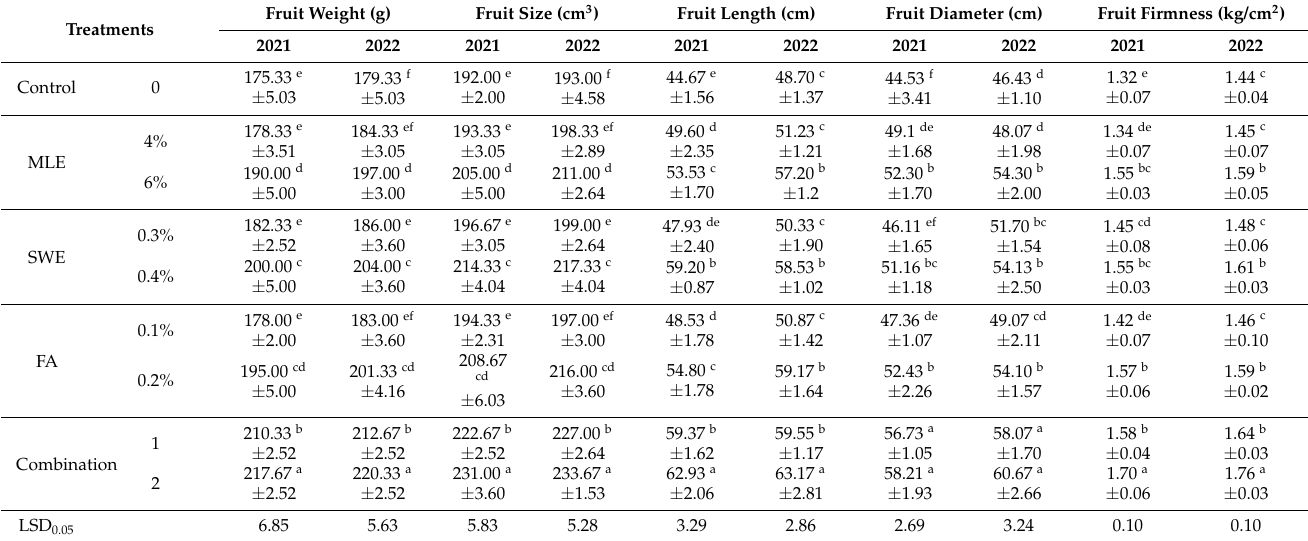
Table 4. The influence of the spraying of MLE, SWE and FA and their combinations on fruit weight, size, length, diameter and fruit firmness of apple cv. Anna during 2021 and